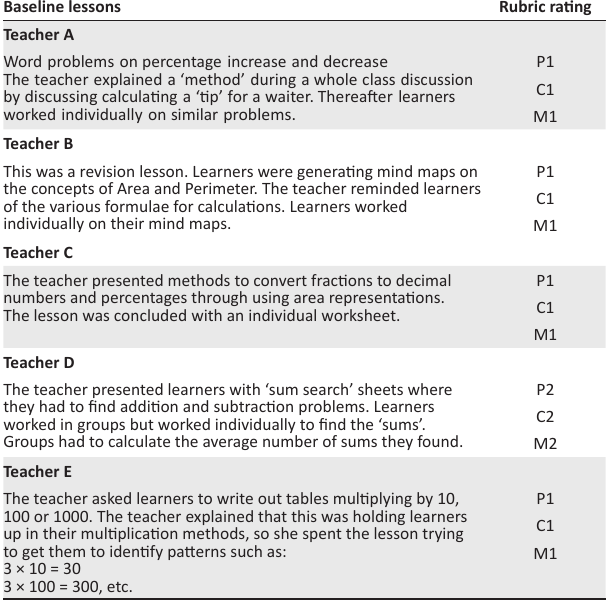
TABLE 1: Summary of baseline lessons.